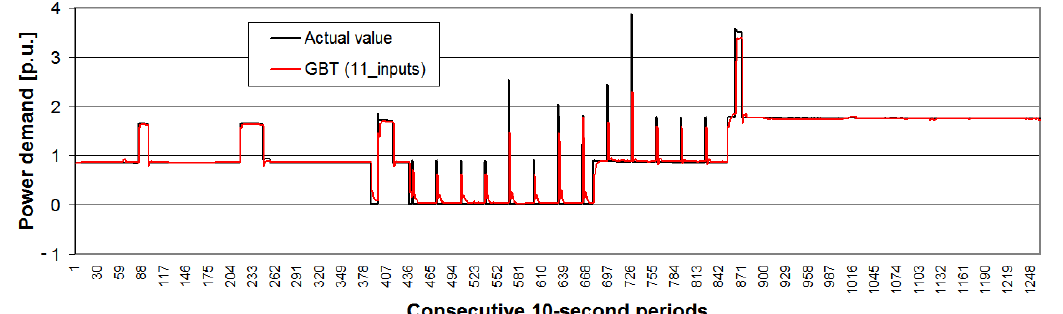
Figure 12. Actual values from the test range (subset) of time series No. 1 and the forecast values by the best method.